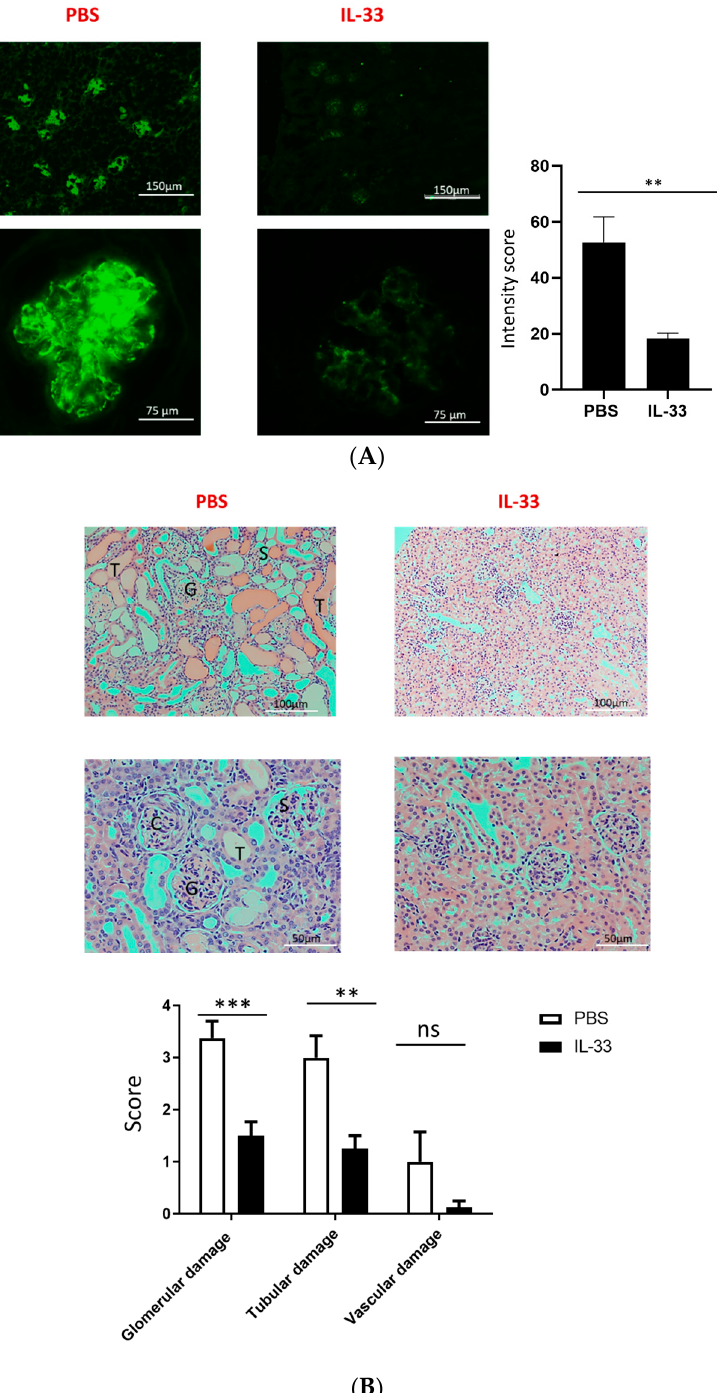
Figure 2. Reduced IgG deposition in the kidney of NZB/W F1 mice treated with IL-33. Beginning at 6 weeks of age, NZB/W F1 mice were given peritoneal treatments of IL-33 or PBS, two times a week for five continuous weeks. ( A ) Representative samples of IgG deposition in the kidney from PBS- (left panel) and IL-33- (right panel) treated 34-week-old NZB/W F1 mice as visualized by immunofluorescence staining. Original magnification 100× (upper panel) and 200× (lower panel). Less IgG deposition was detected in the IL-33-treated mice. Comparison in the intensity score as